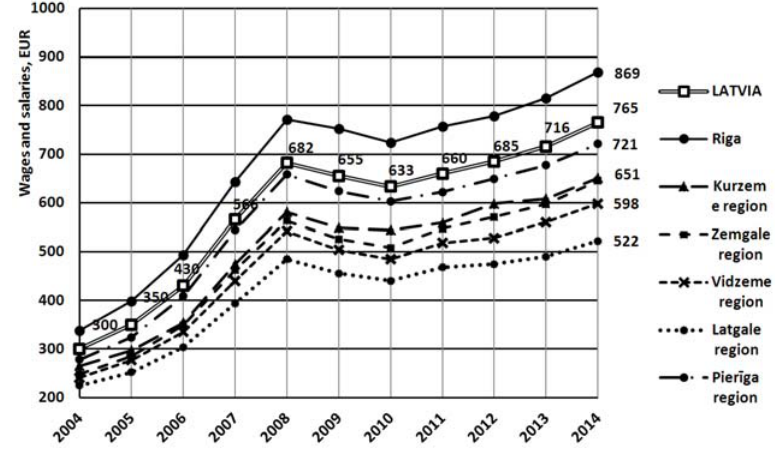
Fig. 3. Average monthly wages and salaries by statistical region of Latvia (in euro) Source: Central Statistical Bureau of